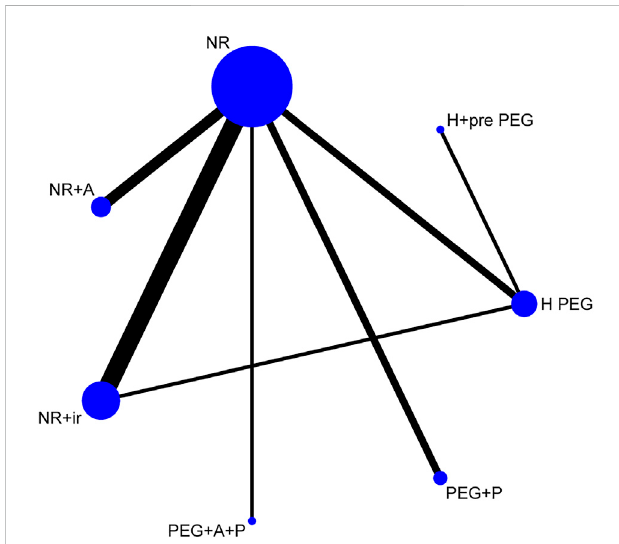
FIGURE 4 Network of comparisons for the Bayesian meta-analysis. Each circle represents a type of regimen. Each line represents direct comparison between two regimens. The width of the linking line is proportional to the number of studies. NR, normal regimen such as using low-volume PEG or NaP; NR + IR, NR plus irritating laxative regimens; NR + A, NR plus advanced intestinal regulation; PEG + P, PEG plus prokinetic agents; PEG + A + P, PEG plus advanced intestinal regulation and prokinetic agents; H PEG, high-volume PEG; H + pre- PEG, H PEG plus once pre-using of